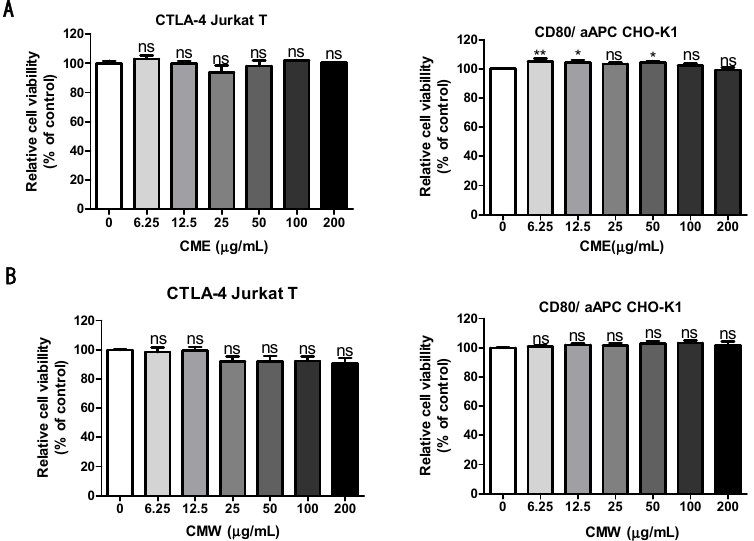
Figure 3. Cell viability e ff ects of the Chaga mushroom / water extract (CMW) and Chaga mushroom / 70% EtOH extract (CME) on CTLA-4 Jurkat T and CD80 / aAPC CHO-K1 cells. CME ( A ) and CMW ( B ) were treated with various concentrations (6.25 to 200 µ g / mL) on CTLA-4 Jurkat T and CD80 / aAPC CHO-K1 cells for 24 h, and the cell viability was assessed using a CCK8 assay. All results are presented as the mean of three independent biological replicates, with * p < 0.05, ** p < 0.01, compared with the vehicle control group.